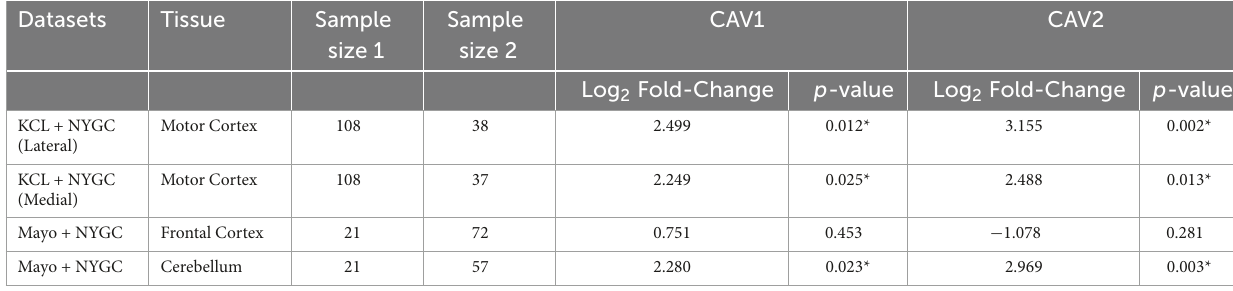
TABLE 2 Stouffer meta-analysis of differential expression data, * p < 0.05.